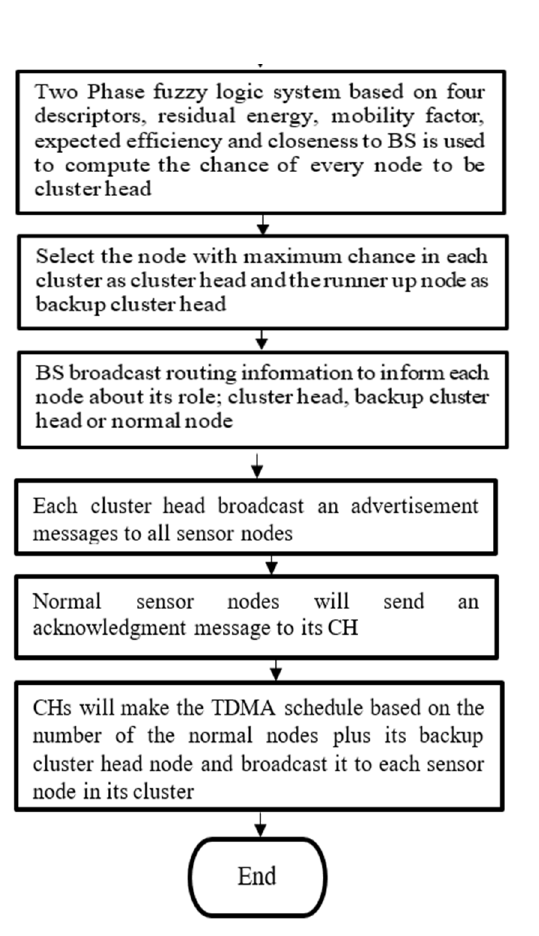
Fig. 3. Flowchart of the Setup